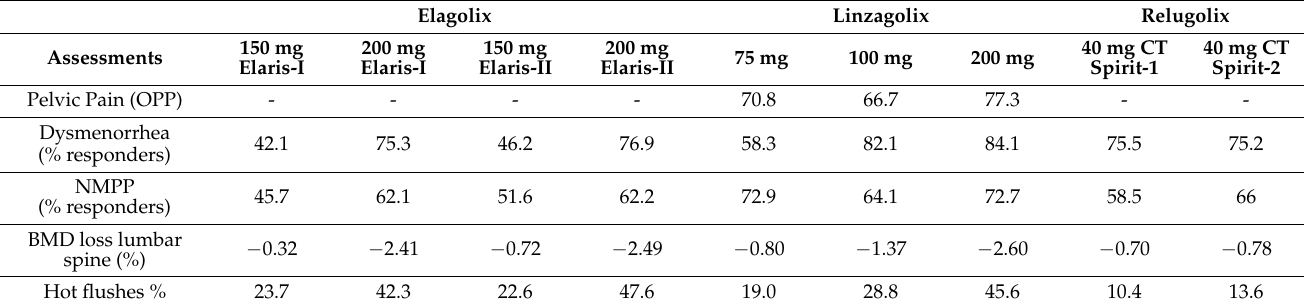
Table 1. Efficacy and side effect of different doses of GnRH antagonist at 24 weeks. Elagolix